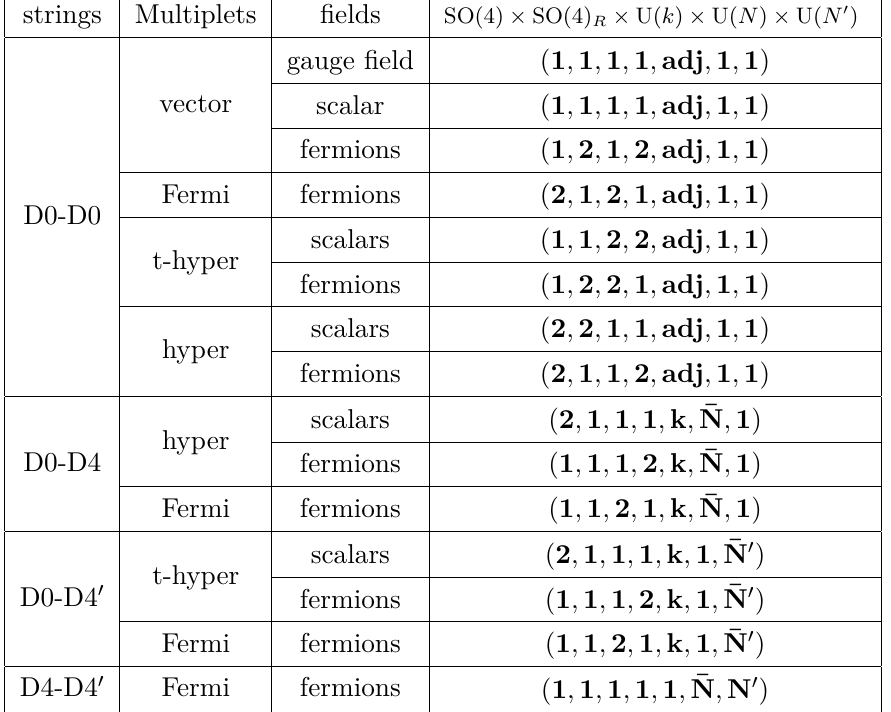
Table 2 . The field content of the quantum mechanics. U( k ) = b G is the D0 brane group, U( N ) = G is the D4 brane group and U( N 0 ) = G 0 is the D 4 0 brane group. SO(4) = SU(2) − × SU(2) + , SO(4) R = SU(2) R × SU(2) R . In this paper, we set N 0 = 1 throughout. t-hyper denotes a (0 , 4) − + twisted hypermultiplet. All multiplets in the second column are (0 , 4) multiplets, with the exception of the last row, which is an honest (0 , 2) Fermi multiplet; still, it can be made compatible with (0 , 4) supersymmetry [30], as is the case